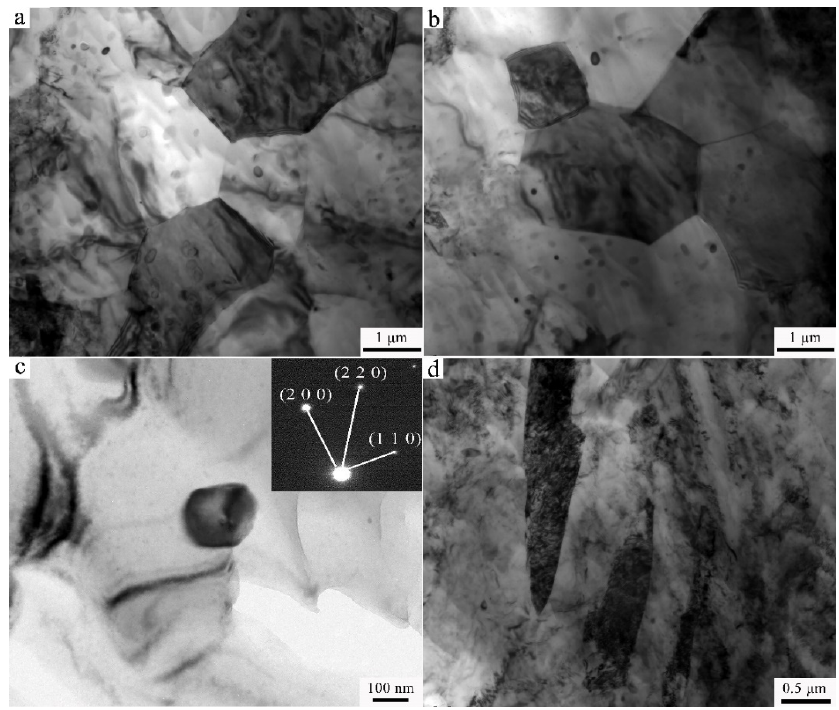
Figure 4. TEM images of Ex-AZ91-Y alloy, ( a ) refined grain, ( b ) recrystallization grain, ( c ) Al-Mn-Y phase, and ( d ) twins.